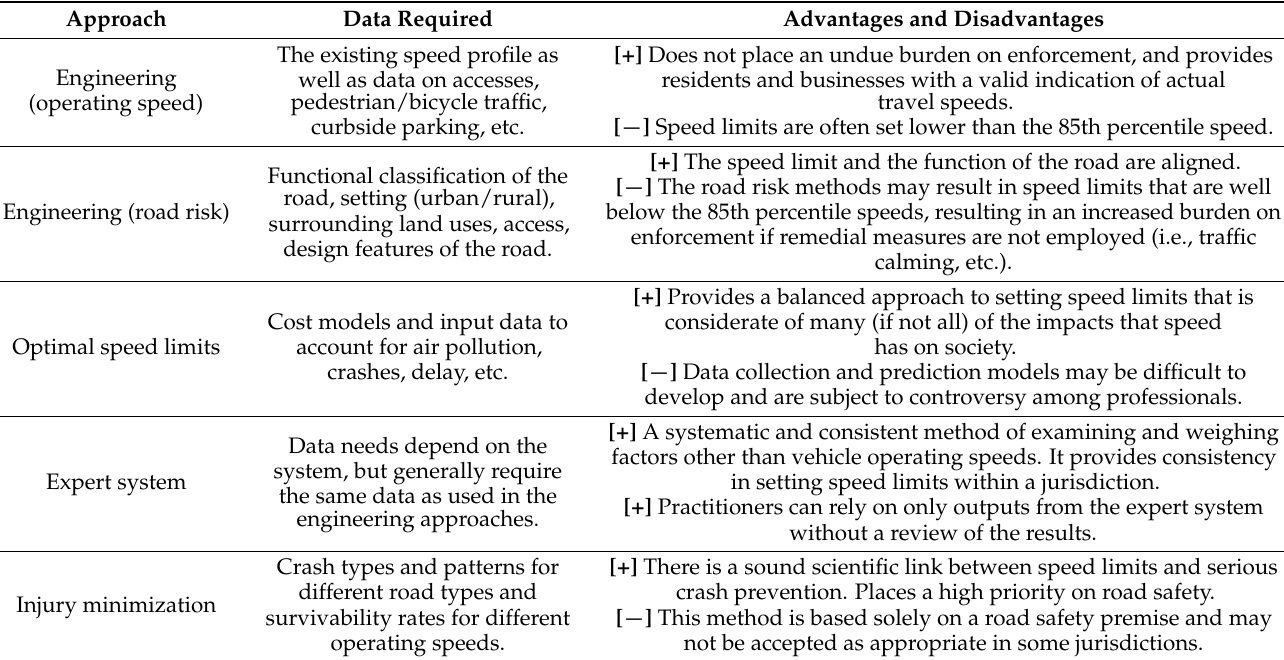
Table 4. Approaches to setting a speed